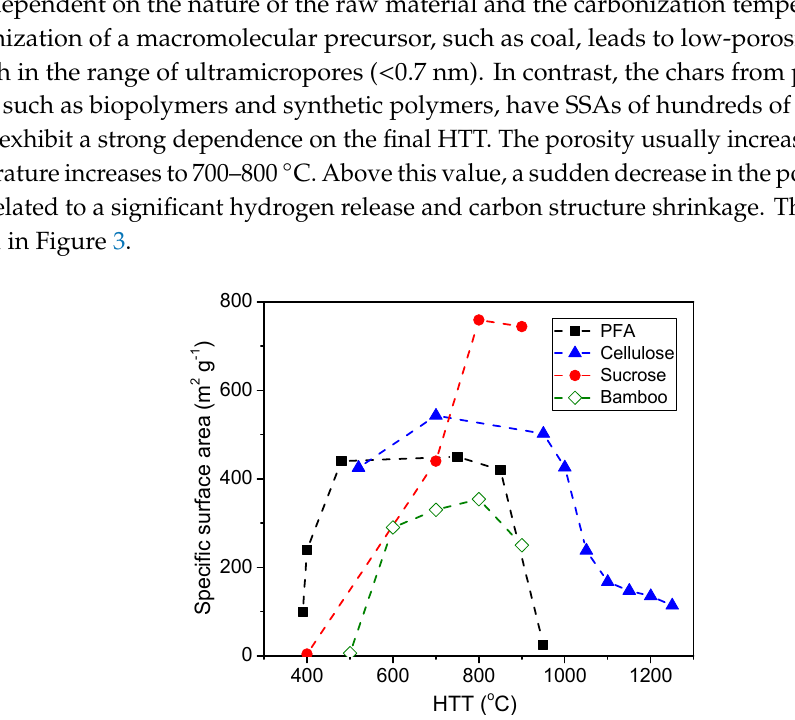
Figure 2. Schematic representation of the structure ( a ). Reproduced from [27] with permission from Elsevier © 1990, and a typical HRTEM image of an AC ( b ).